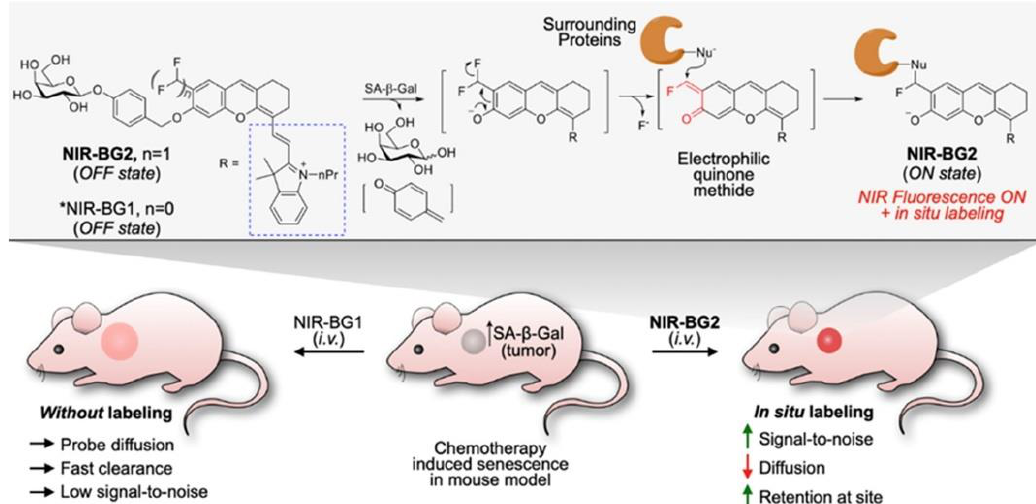
Figure 14. Activation of self-immobilizing probe NIR-BG2 and control probe NIR-BG1. Reprinted with permission from [64], copyright 2021 American Chemical Society. For a summary of fluorogenic glycosidase probes, see Table 5. Table 5. Fluorogenic activity-based probes for different glycosidases. Structure a